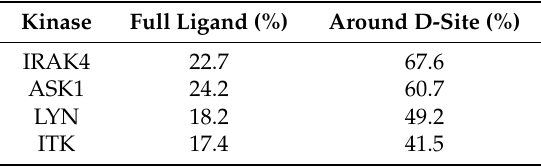
Table 3. Shape similarity between TWNs and compound 1